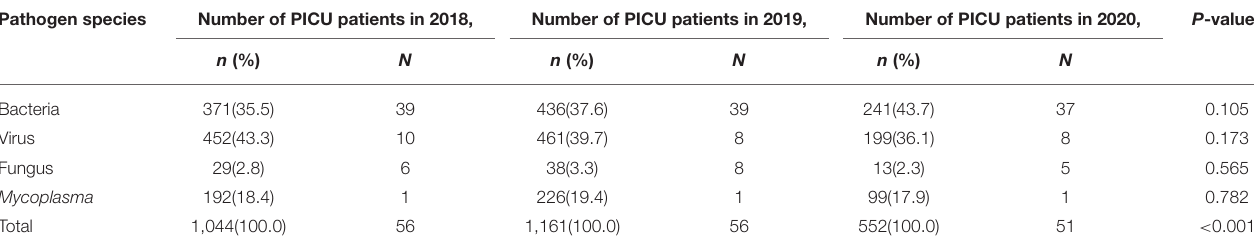
TABLE 3 | Etiological results of the patients admitted to the pediatric intensive care unit by year (2018–2020). Pathogen species Number of PICU patients in